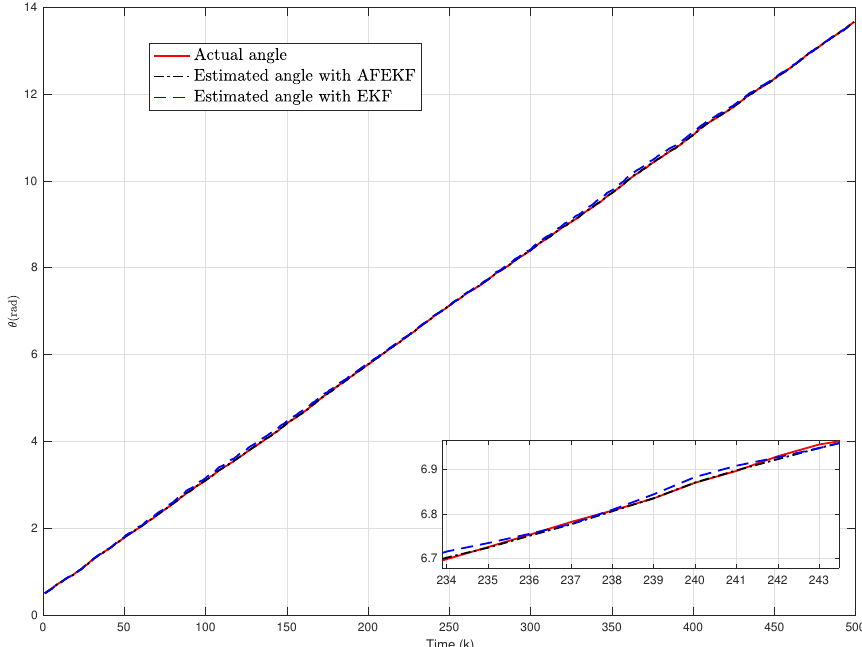
Figure 11. Robot’s angle and its estimates under uncertainty.